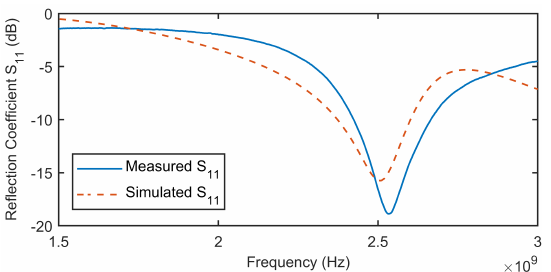
Figure 15. AM patch antenna reflection coefficient S 11 simulation and test